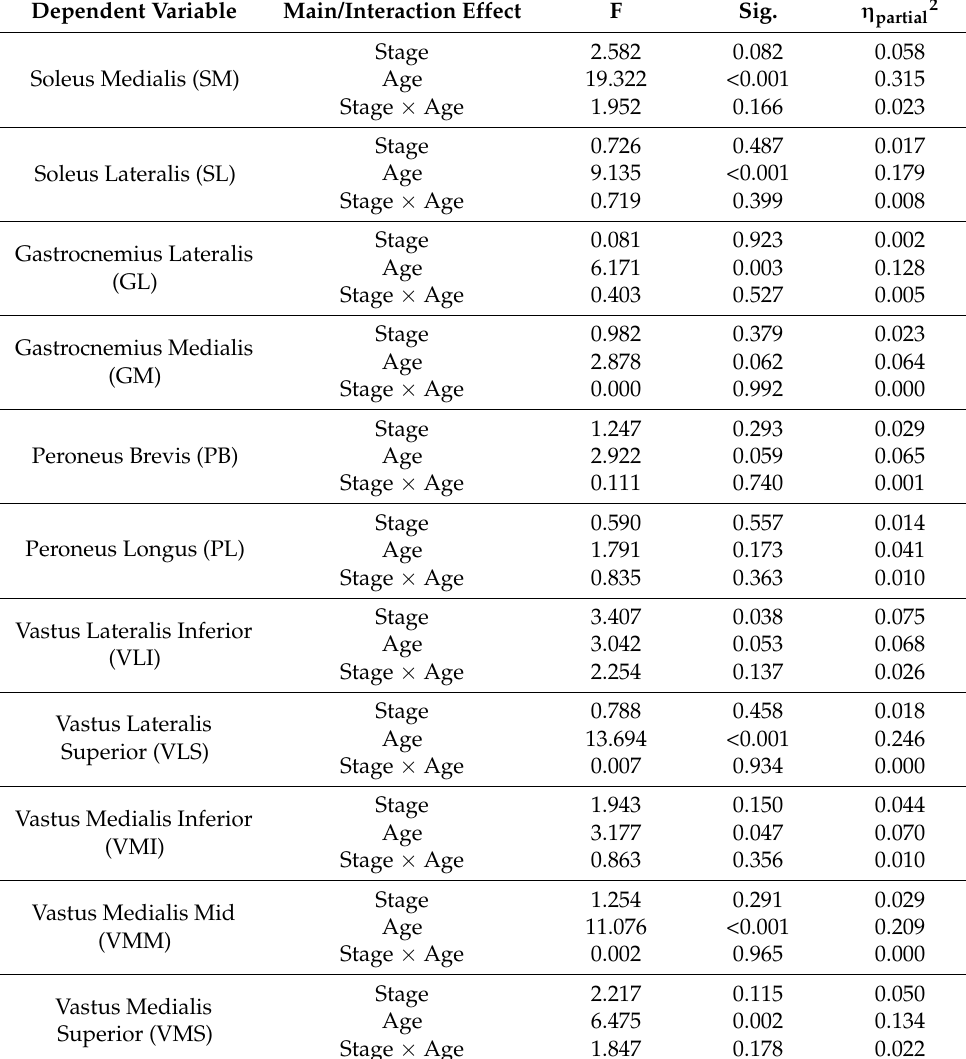
Table 7. Results of main and interaction effect of muscle force